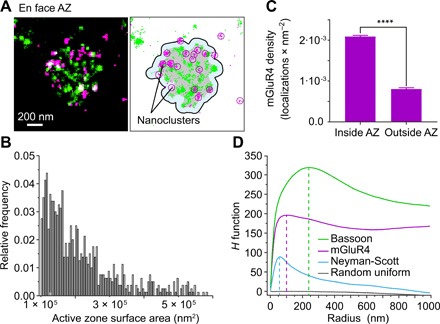
Organization of mGluR4 at parallel fiber AZs.(A) Principle of the analysis. En face AZs were identified on the basis of the bassoon localizations (green dots) using the DBSCAN algorithm (53). Gray color indicates the AZ area identified by the analysis. mGluR4 nanoclusters (magenta circles) were subsequently identified on the basis of the mGluR4 localizations (magenta dots) using DBSCAN (see fig. S1 for details). (B) Histogram reporting the surface areas of the analyzed en face AZs. (C) Comparison of mGluR4 localization densities inside and outside AZs. n = 799 AZs. Data are means ± SEM. ****P < 0.0001 by two-sided paired t test. (D) Ripley’s H function analysis investigating the clustering of mGluR4 and bassoon on different length scales. Data were compared with a Neyman-Scott distribution (n = 20 and σ = 20 nm) to simulate randomly distributed localization clusters and with random uniformly distributed localizations. H maxima were observed at approximately 240 nm (bassoon), 100 nm (mGluR4), and 60 nm (Neyman-Scott).